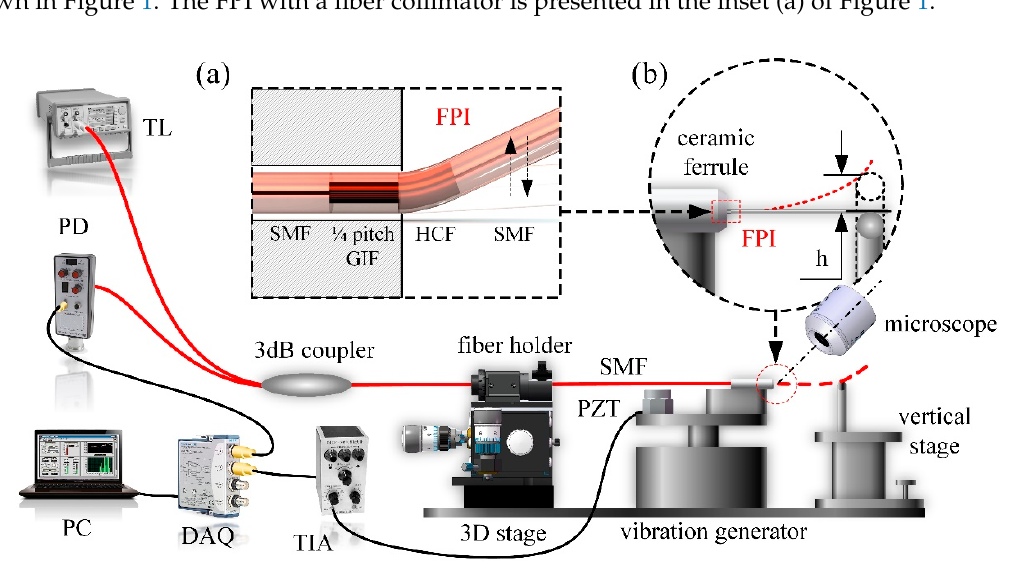
Figure 1. A schematic diagram of the proposed vibration sensor system (TL: tunable laser; FPI: Fabry-Perot interferometer; 1/4 pitch GIF: a quarter pitch graded index fiber (fiber collimator); SMF: single mode fiber; HCF: hollow-core fiber (air cavity of the Fabry-Perot interferometer); PD: photodiode; PZT: piezoelectric transducer; TIA: transimpedance amplifier; DAQ: data acquisition board; PC: personal computer). Insets ( a ) and ( b ) show the FPI sensor structure and the detailed schematic of the FPI sensor with a lateral displacement, respectively.